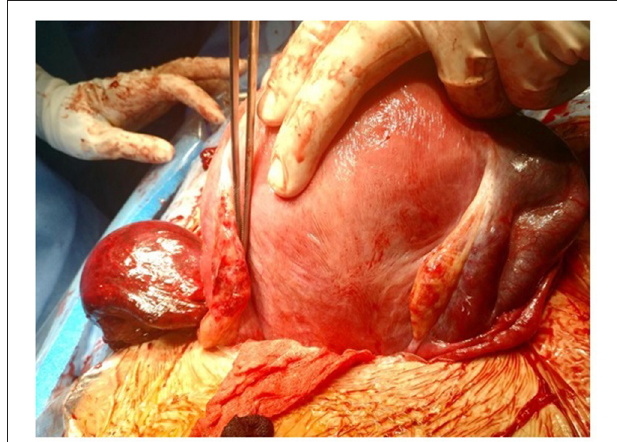
FIGURE 1 | Triple isolated torsion of left Fallopian tube with healthy